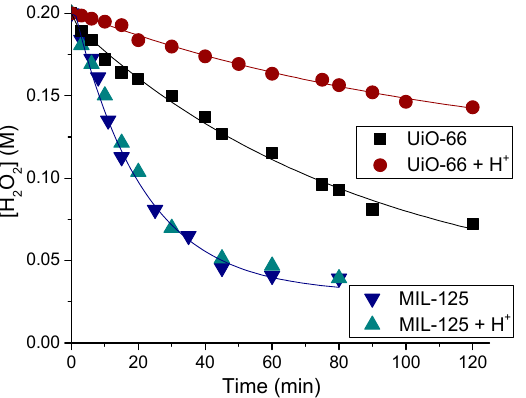
Figure 5. Effect of acid on H 2 O 2 decomposition over UiO-66 and MIL-125. Reaction conditions: H 2 O 2 0.4 mmol, catalyst 0.04 mmol of Zr or Ti, HClO 4 0.04 mmol (if any), CH 3 CN 2 mL, 50 °C.